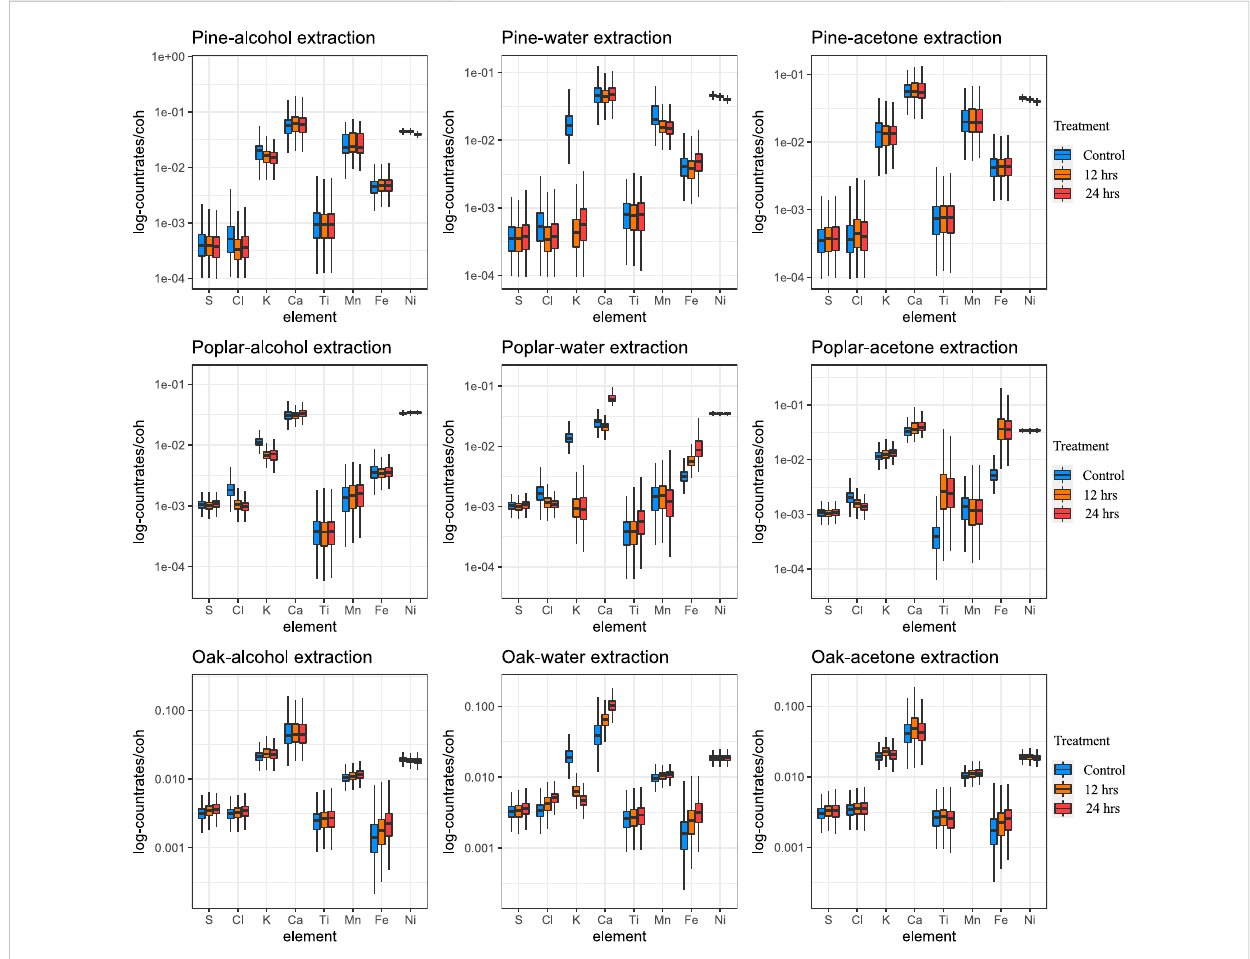
FIGURE 3 Boxplots showing the countrates for all selected elements for pine, poplar and oak and the three solvents used (ethanol, water, and acetone). All countrates were divided by the coherent scatter to account for changing matrix conditions. y-Axes are log transformed to ease comparability between elements with very different medians. Results of the ANOVA post hoc test for group comparison are reported in Table 1. Blue: control; orange: 12 hrs extraction time; red: 24 hrs extraction